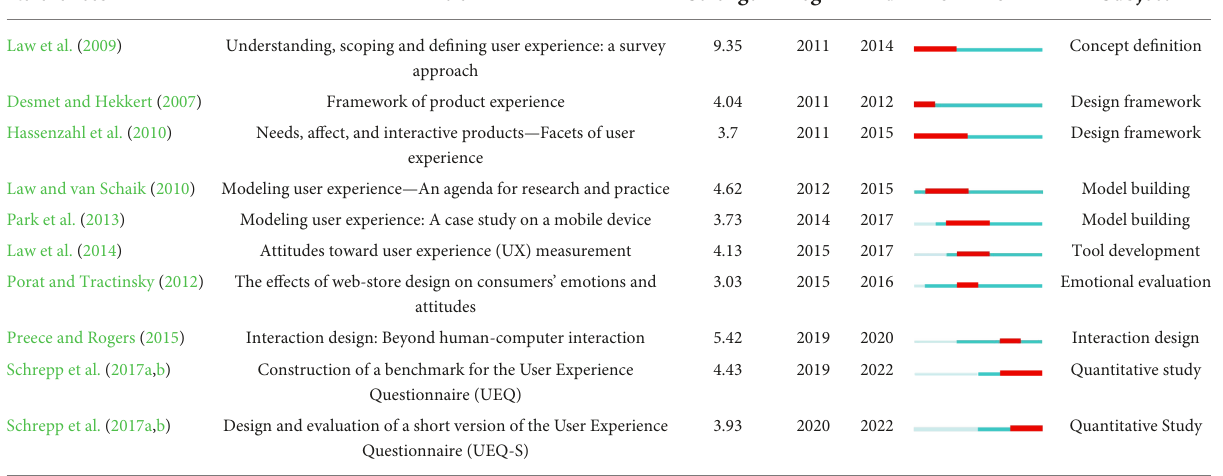
TABLE 3 Mutation analysis of top 10